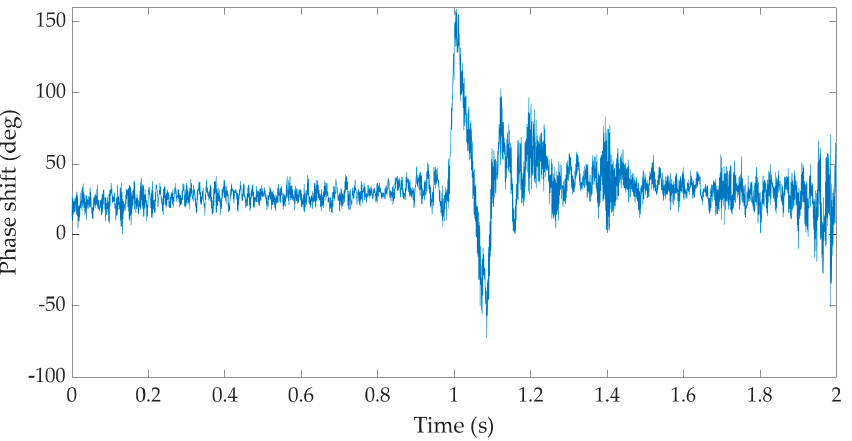
Figure 7. Time recording of one hammer strike during the implementation of a gravel pile from the fiber-optic system under development—measurement diagram M4.1a.